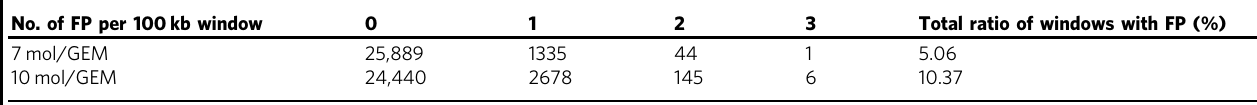
Table 1 Number of false positive (FP) molecules identi fi ed by ReMIX at 7 and 10 molecules per GEM No. of FP per 100 kb